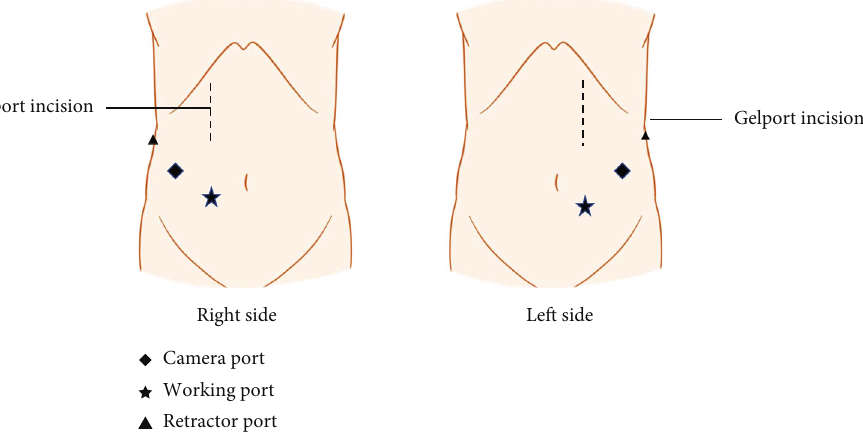
Figure 1: Placement of the hand port and trocars.